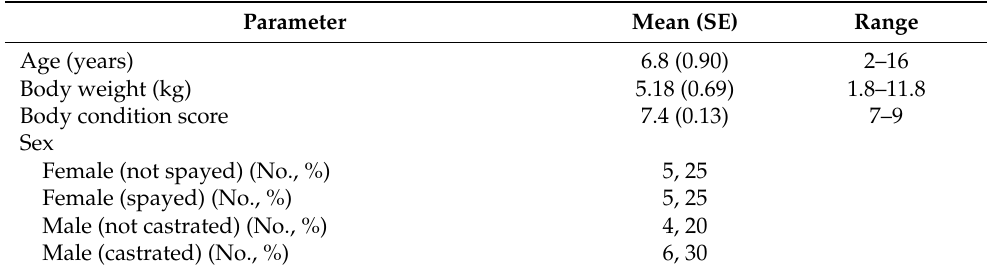
Table 1. Clinical baseline characteristics of the tracheal collapse dogs at the beginning of the study ( n =